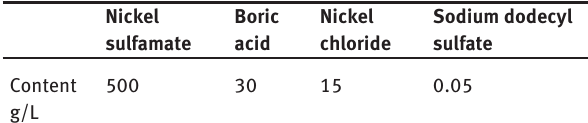
Table 2: The composition of the solution.